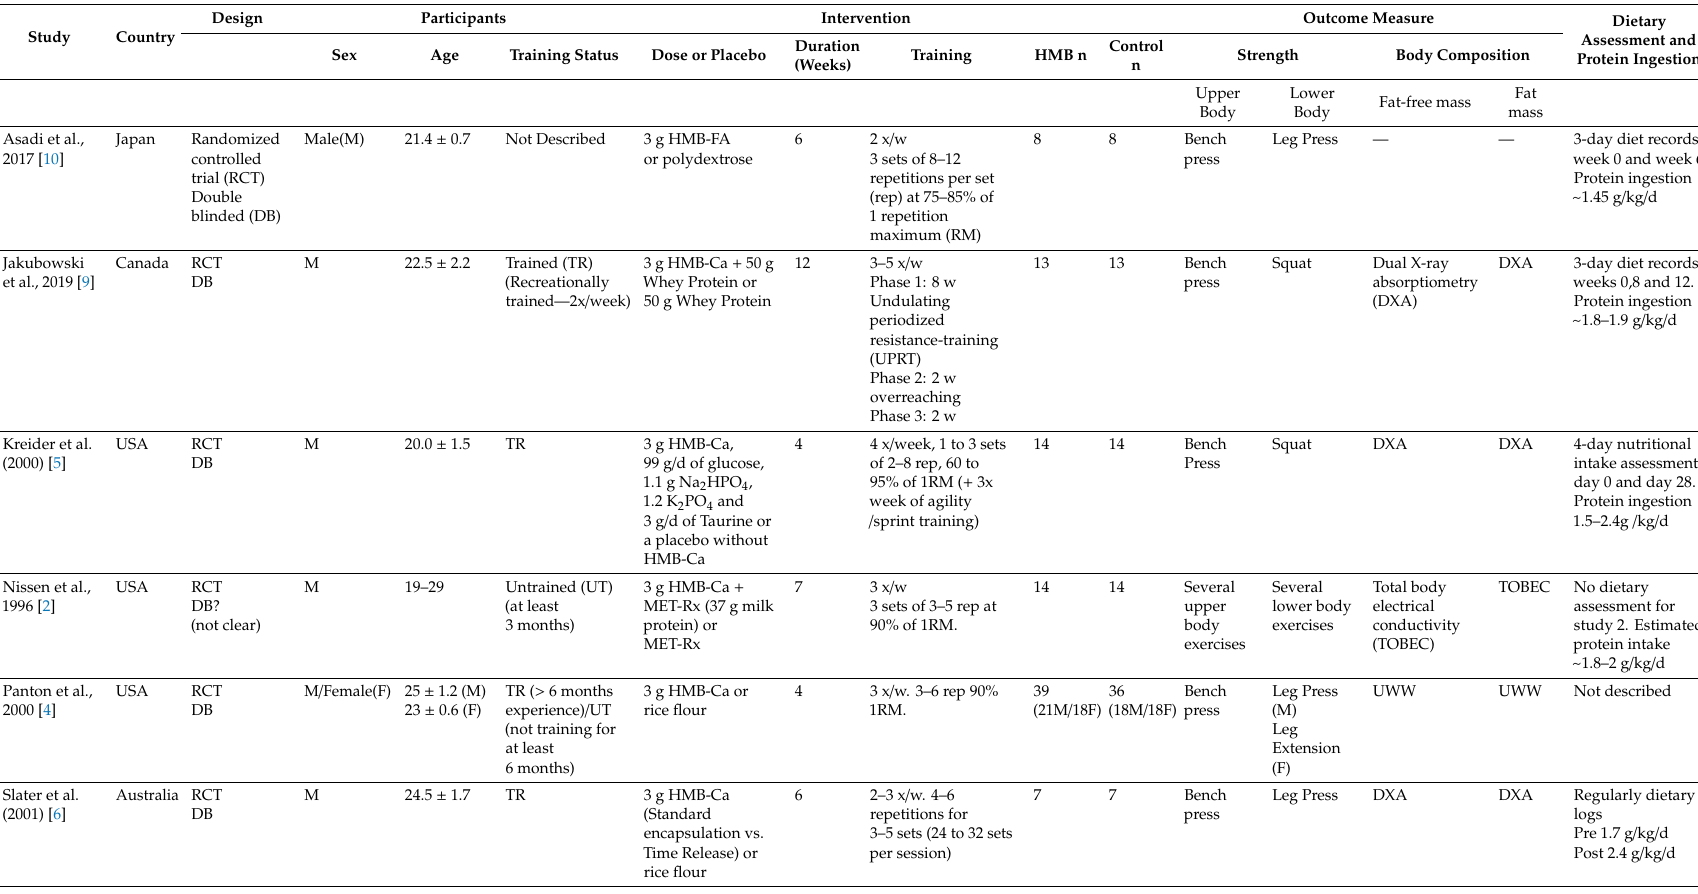
Table 2. Characteristics of the analysed